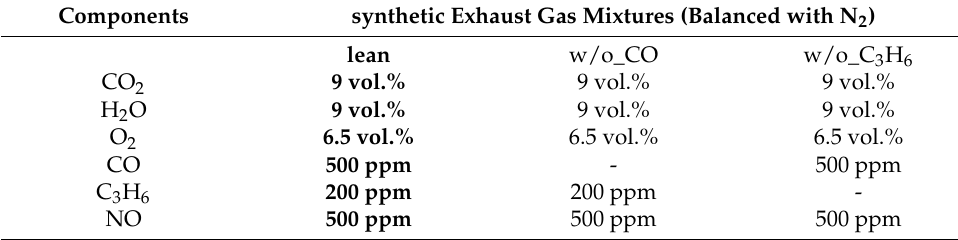
Table 1. Exhaust gas compositions used in C 3 H 6 -SCR